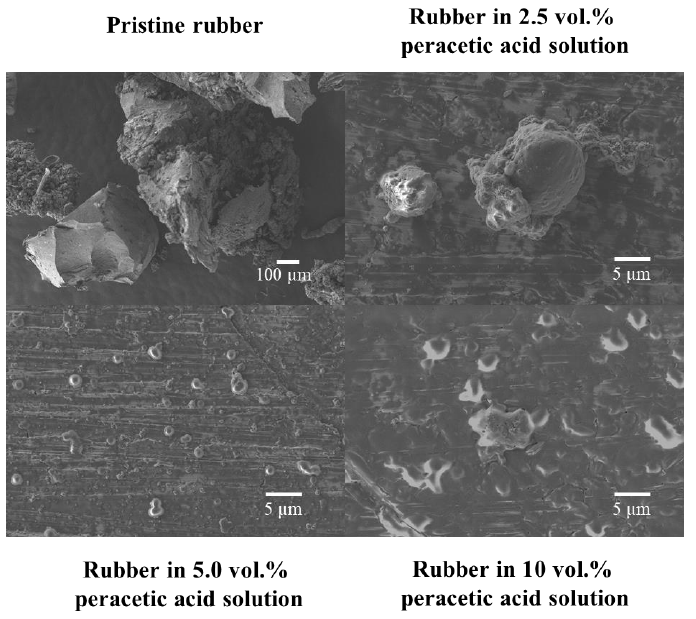
Figure 2. SEM images of pristine rubber and rubber submitted to different concentrations of peracetic acid solutions.